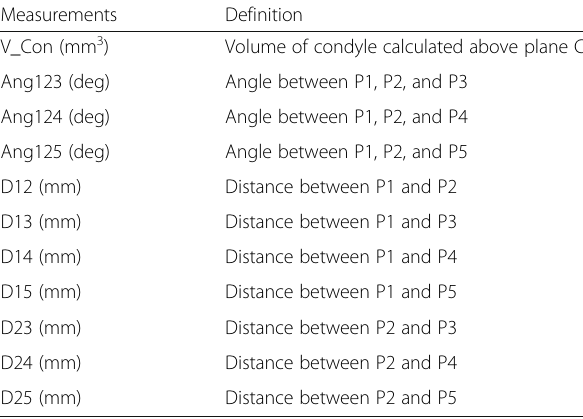
Table 1 Definition of the volume of condyle angle and distance measurement Measurements